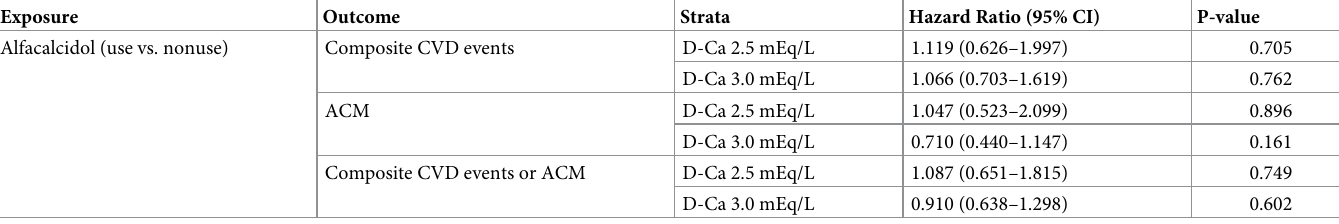
Table 2. Estimated association of alfacalcidol use with the two outcomes stratified by dialysate calcium concentration. Exposure Alfacalcidol (use vs. nonuse)